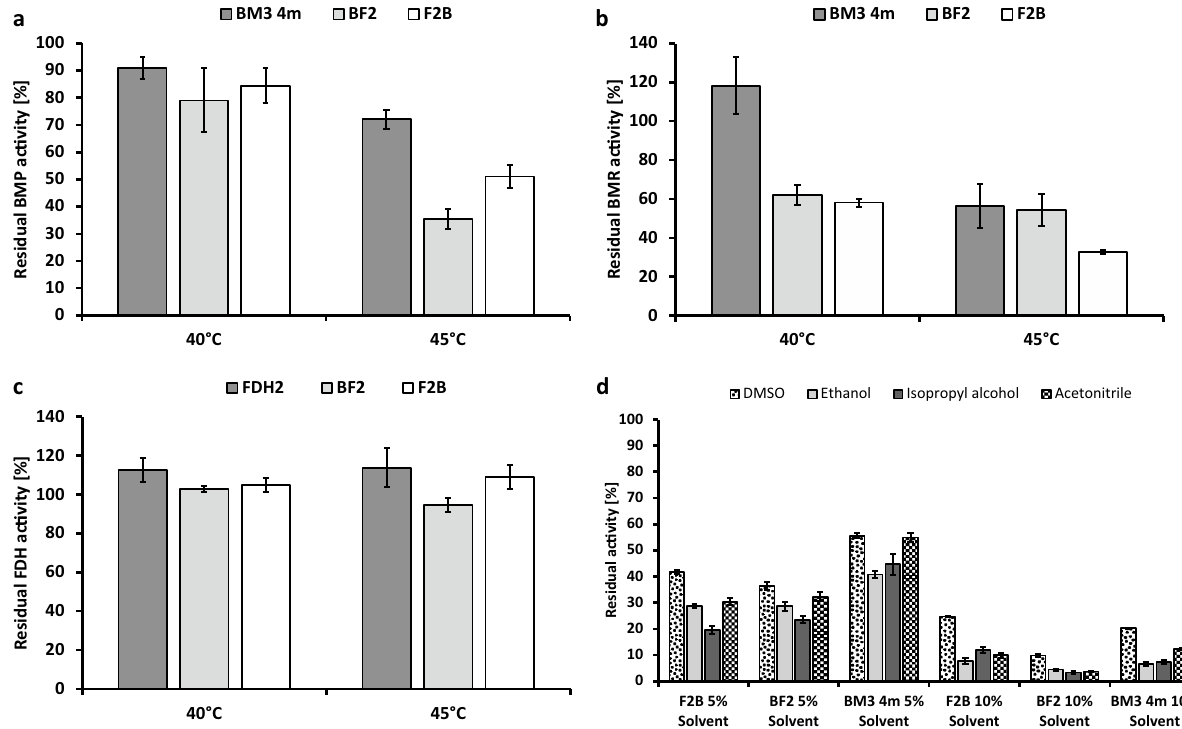
Figure 3. Thermal ( a – c ) and solvent stability ( d ) of individual BM3 4m and FDH as well as fusion constructs F2B and BF2. ( a ) Activity values were measured after incubation at 40 °C and 45 °C. The resulting values were normalized to values obtained after incubation at 25 °C (= 100%). Standard deviation is shown as error bars. Measurements were conducted in KPi buffer (50 mM, pH 8.1) with 12- p NCA (0.07 mM, dissolved in DMSO), NADPH (0.5 mM) and purified enzyme (50 nM). ( b ) Samples consisted of Tris–HCl (50 mM pH 7.5), potassium ferricyanide (1 mM), NADPH (0.5 mM) and purified enzyme (5 nM). ( c ) FDH activity was determined with samples consisting of KPi (50 mM, pH 7.5), sodium formate (0.6 M), NADP + (1 mM) and purified enzymes (50 nM). ( d ) For the determination of solvent stability, conversion of 12- p NCA at 5% and 10% solvent concentration was normalized to the values measured at 2% of the appropriate solvent (= 100%). Samples consisted of KPi (50 mM pH 8.1), 12- p NCA (0.07 mM), NADPH (0.5 mM) and varying concentrations of DMSO, ethanol, isopropyl alcohol and